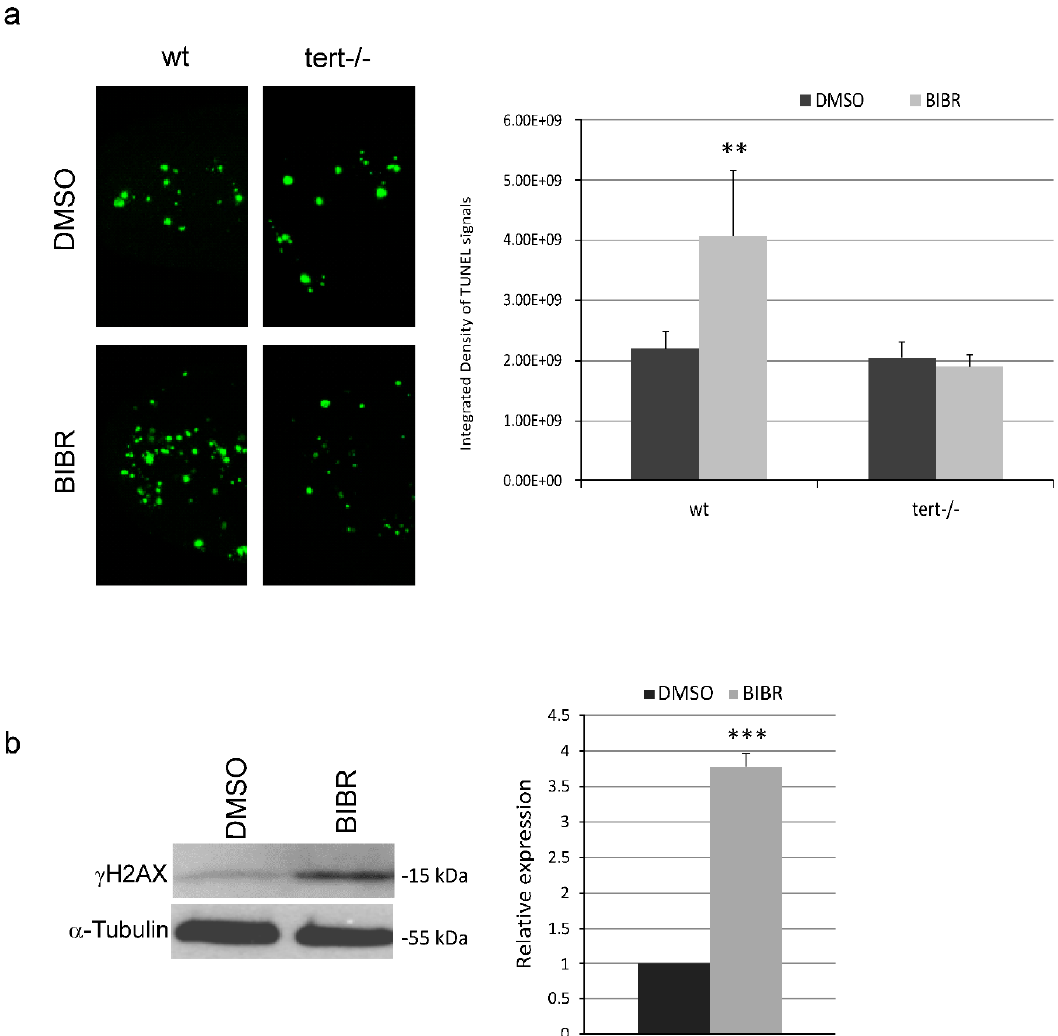
Figure 2. Tert inhibition in zebrafish embryos induces apoptosis and activates DNA damage responses (DDR). ( a ) Representative images of terminal deoxynucleotidyl transferase dUTP nick end labeling (TUNEL) assay in wt and tert − / − embryos treated with BIBR or DMSO from 12 to 24 hpf. The quantification analysis of apoptotic foci in the caudal portion, as integrated density values, was made by ImageJ software. The graph on the right shows the relative means and SD (bar) of apoptotic foci in 20 embryos per group. ( b ) Representative western blot analyses of phosphorylated H2A histone family, member X ( γ H2AX) protein (15 kDa) level, detected by specific antibody, and normalized on tubulin content. The graph on the right shows densitometry analysis in arbitrary units performed with ImageJ software. Data represent the mean and SD (bar) from three separated experiments with value of 1 assigned to DMSO-treated controls (relative expression). A significant difference between values in BIBR-treated embryos versus DMSO-treated embryos is shown: ** p < 0.01, *** p < 0.001.